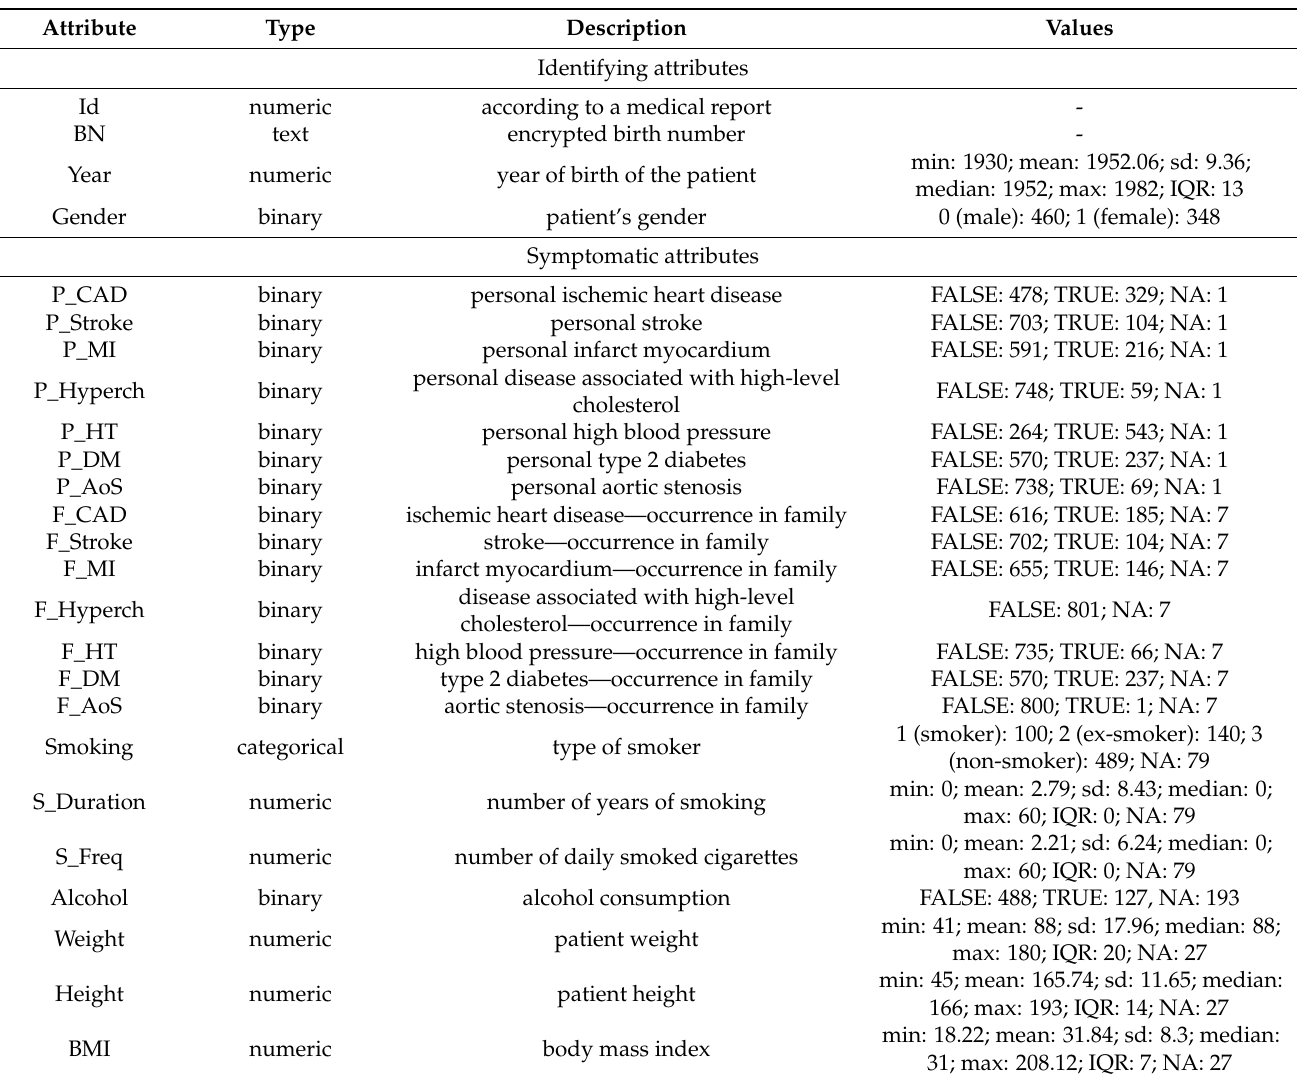
Table 1. Overview of